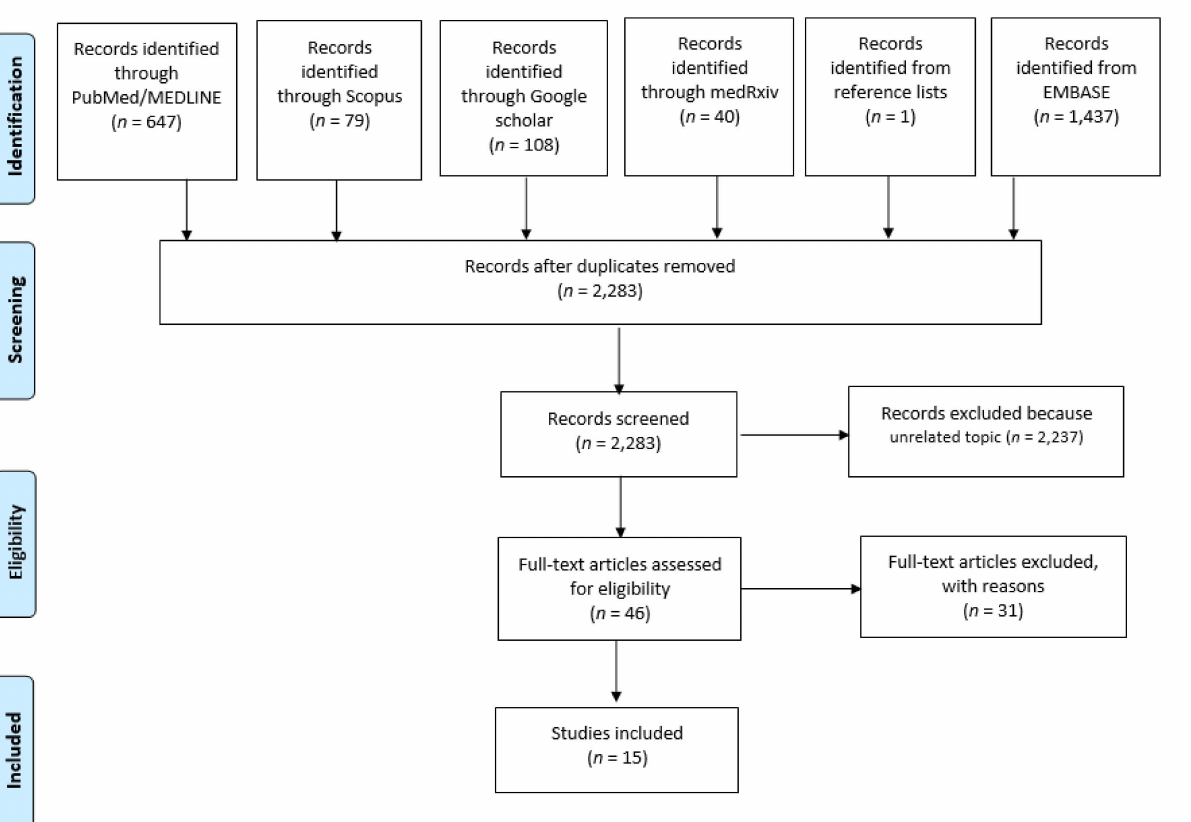
Figure 1. Flow diagram of the selection